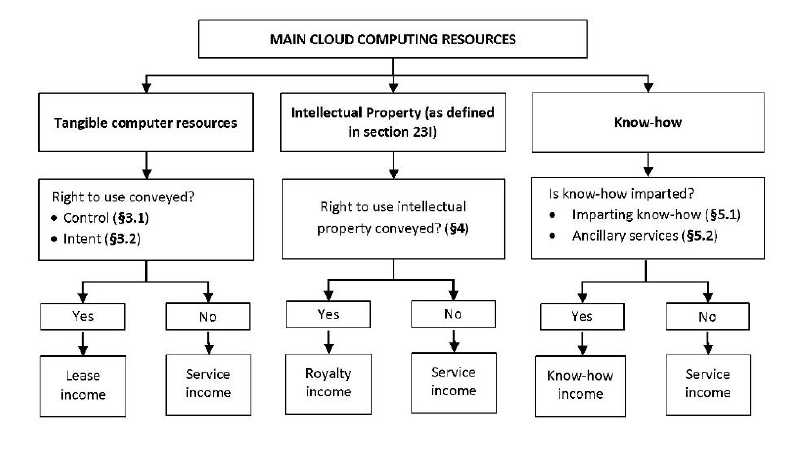
FIGURE 1: Main cloud computing resources and its possible income tax classifications